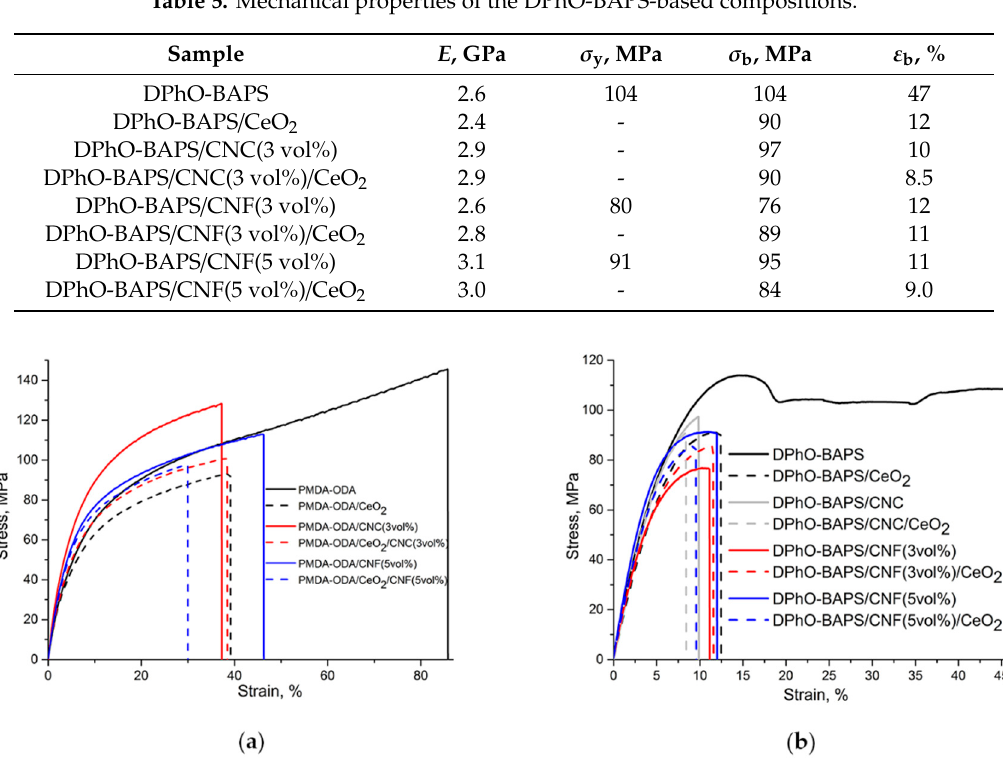
Figure 8. Stress-strain curves of the samples: ( a ) PMDA-ODA-based compositions; ( b ) DPhO-BAPS-based compositions. Table 4. Mechanical properties of the PMDA-ODA-based compositions.